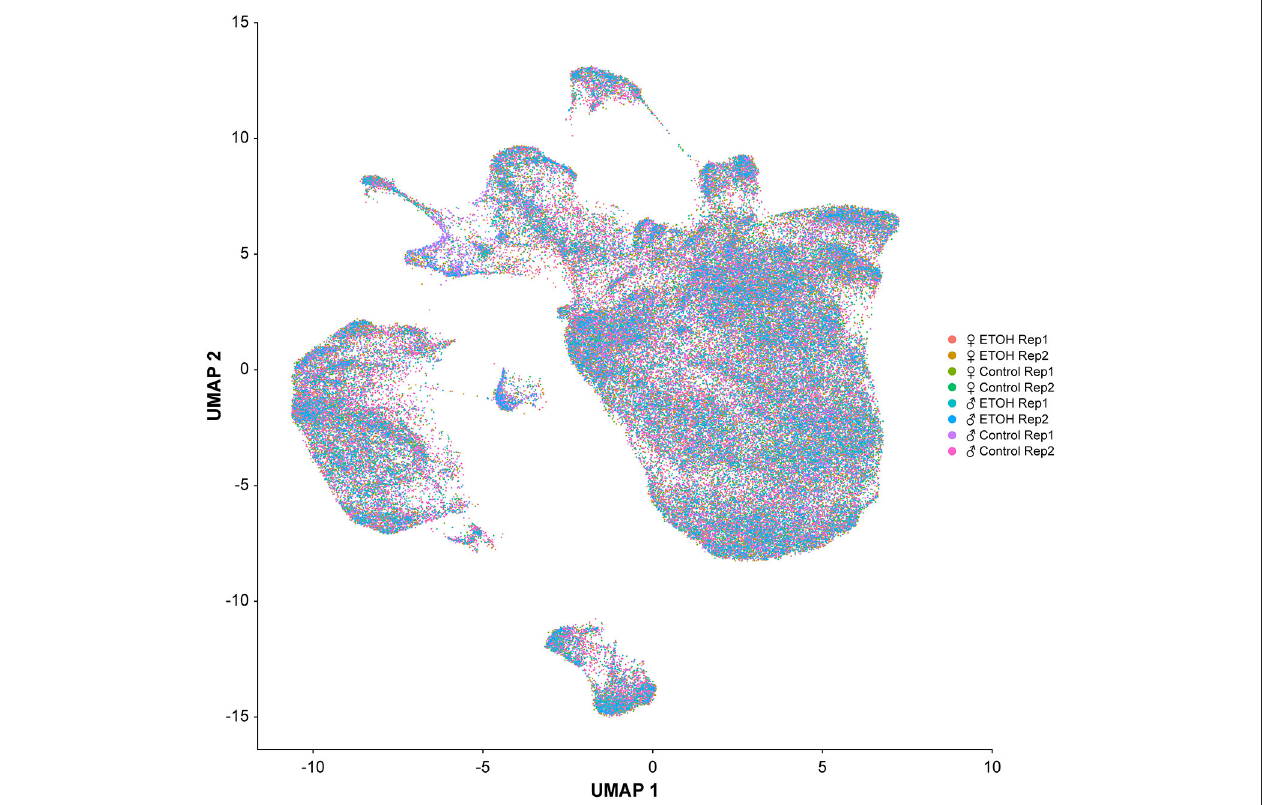
FIGURE 3 | Uniformity across samples of single cell transcriptomes. Gene expression patterns of single cells ( n = 108, 571) from all eight samples are represented in low dimensional space using a graph-based, non-linear dimensionality reduction method (UMAP). Individual dots represent the transcriptome of each cell and the colors of the dots represent the samples to which the cells